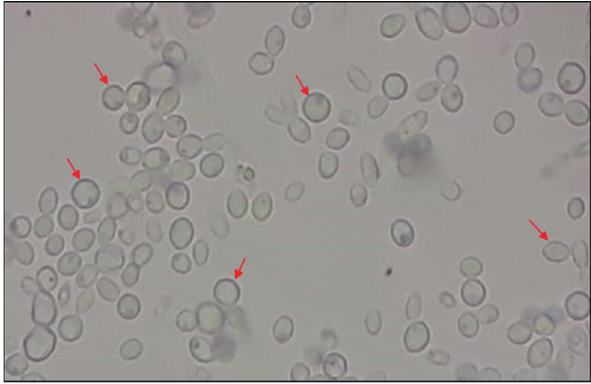
Figure 2: Appearance of yeast in a fresh culture ( ×